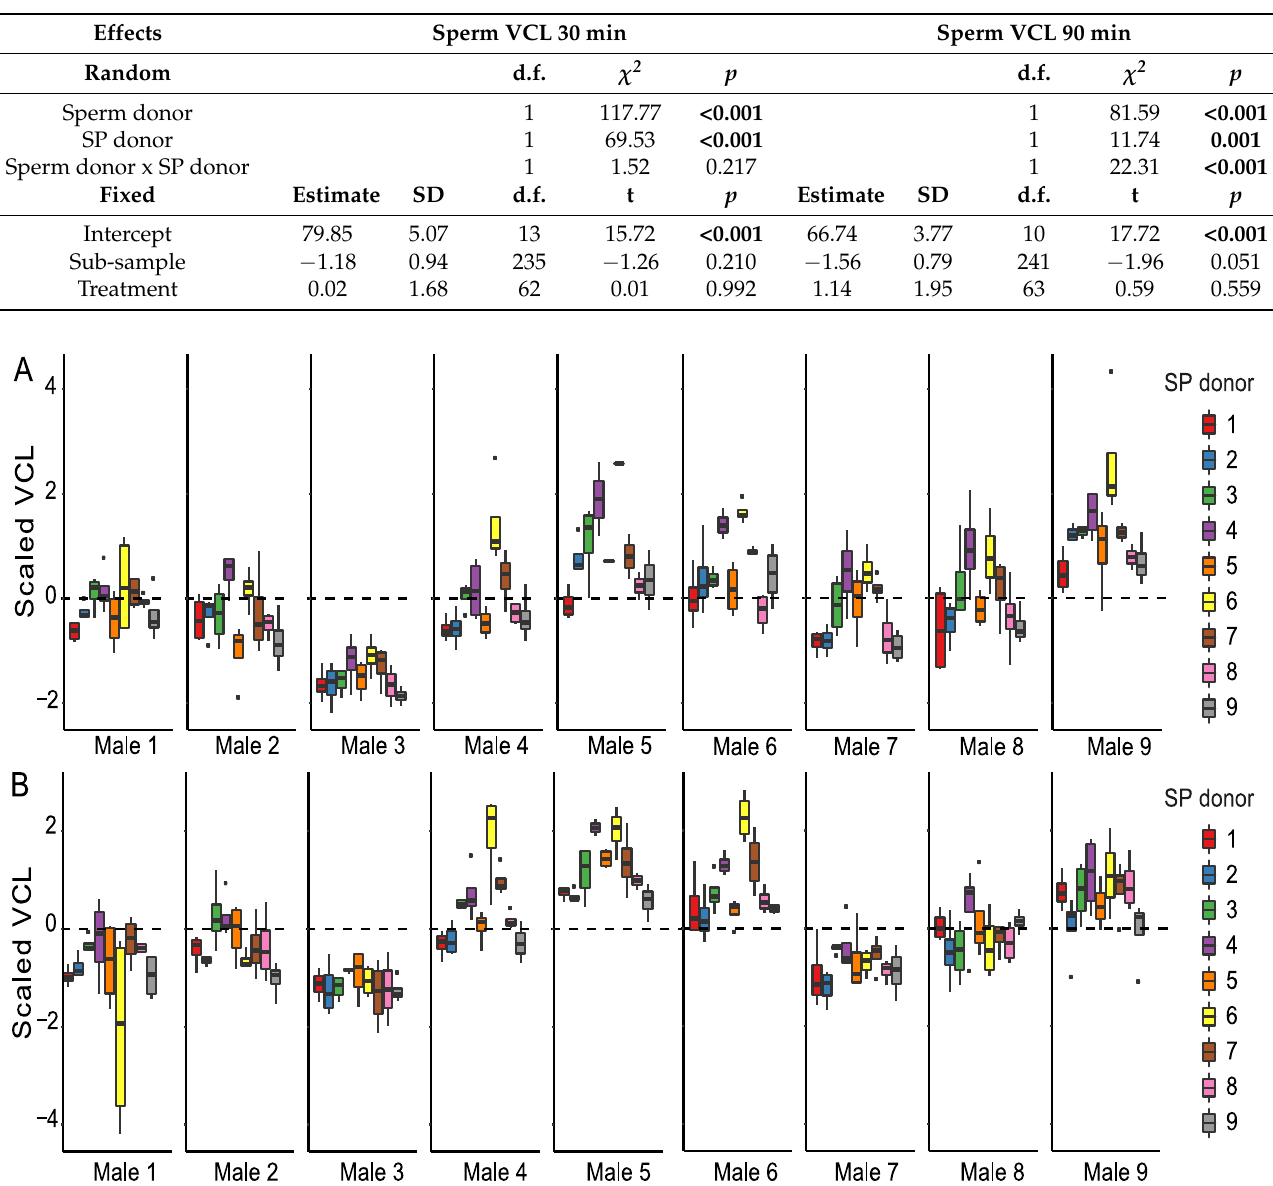
Table 4. Linear mixed model (LMM) statistics for the effect of sperm donor, SP donor, and their interaction (random effects) on sperm swimming velocity (VCL) at two time points (30 and 90 min) after the initiation of the SP treatment. Models also included fixed effects of sub-sample and treatment (own or foreign SP).